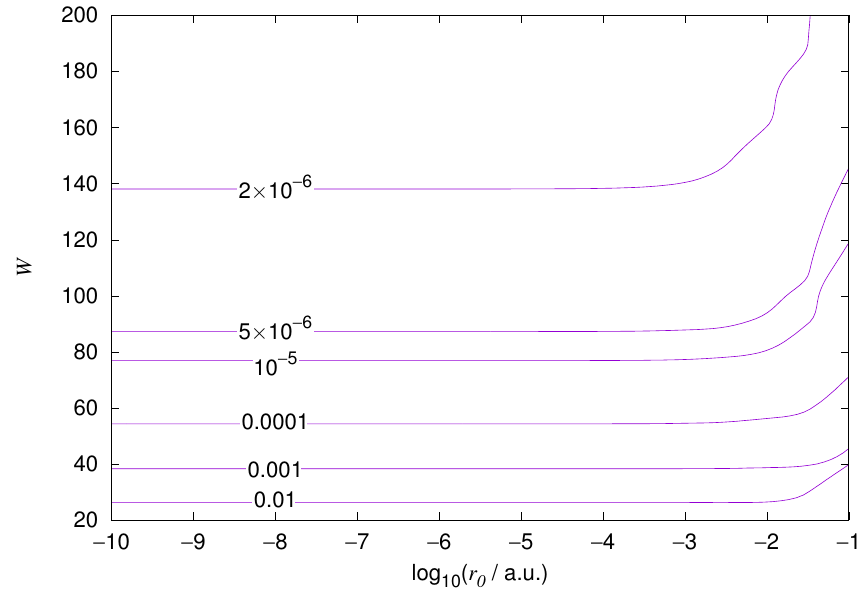
Figure 3. Hydrogen 2s orbital eigenenergy relative error. Notations as in Figure 1.